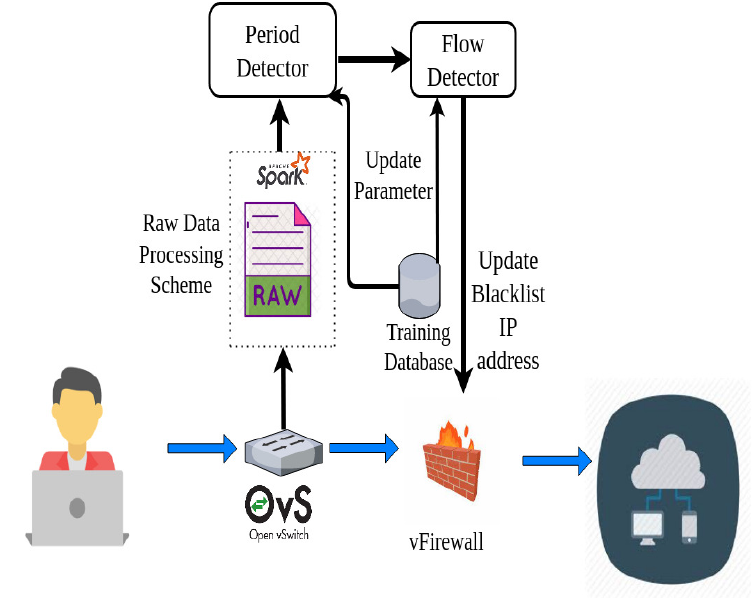
Figure 4. Conceptual architecture of the proposed